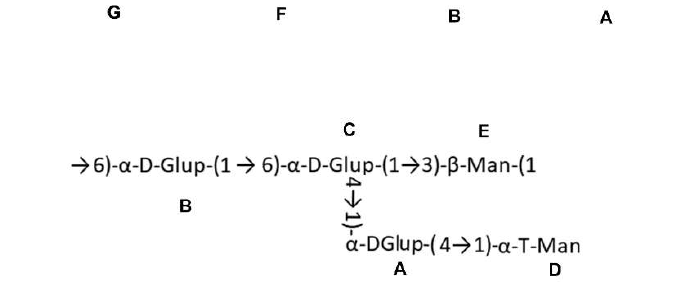
Figure 5. Putative fragments of the structure of NMCP-2. A–G are units of glycosyl residues.